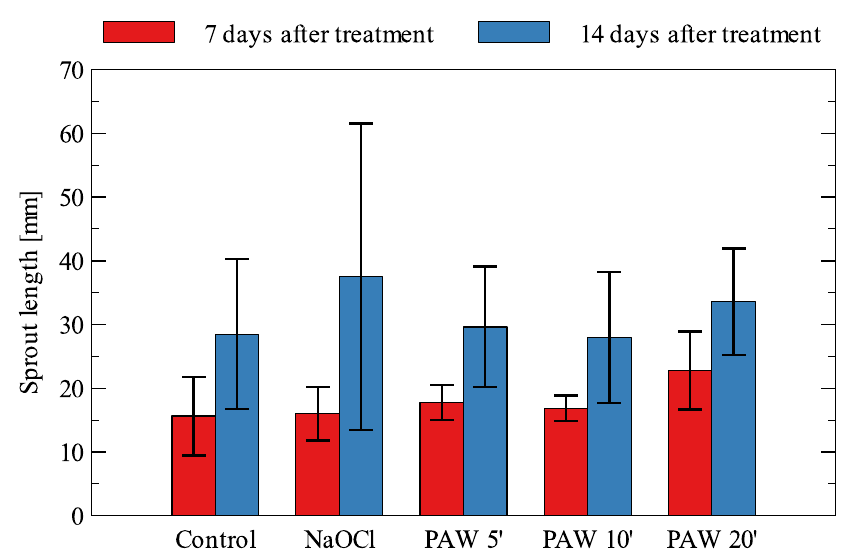
Figure 4. Sprout length of Beta vulgaris (mean values and standard deviation).